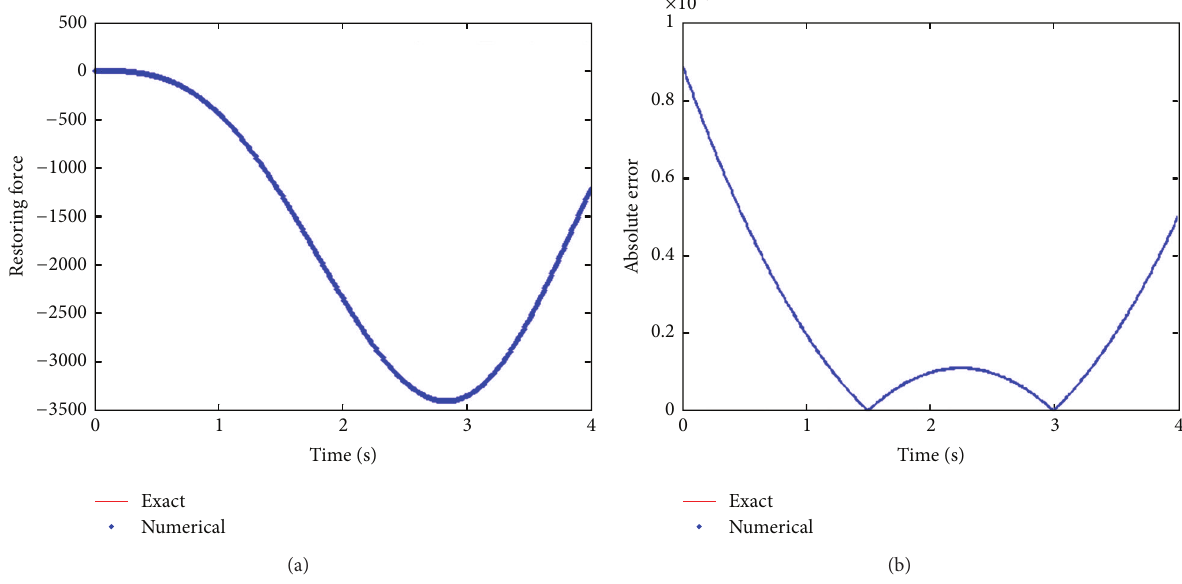
Figure 7: For Example 2, (a) comparing exact solution and numerical one for restoring force with 𝑇 0 = 2×10 5 and 𝑚 = 500 under 4 seconds and (b) displaying the estimated error of restoring